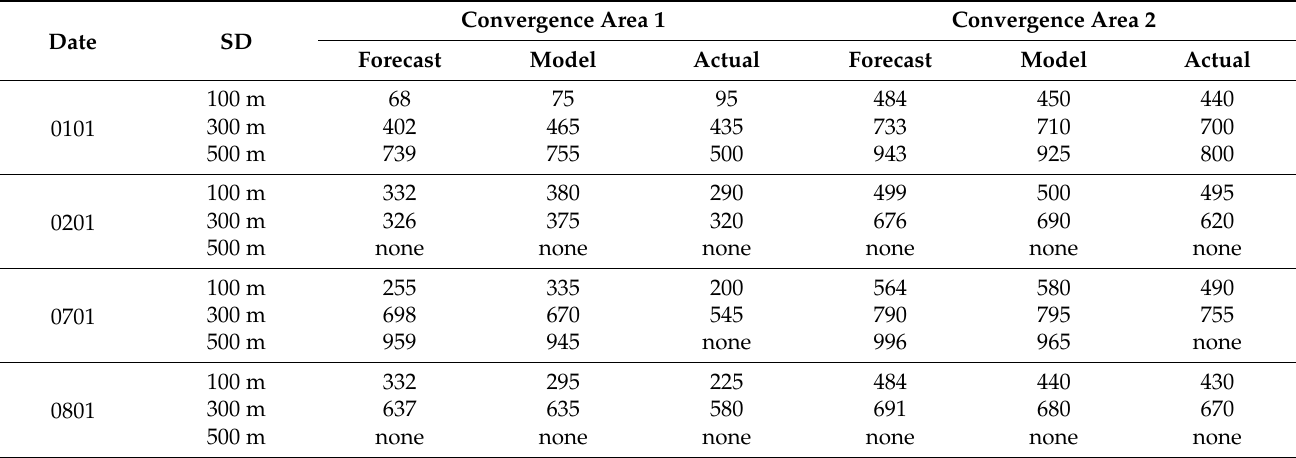
Table 5. Comparison of the effectiveness of forecasting the depth changes of the convergence area at different sound source depths at different times (f = 50